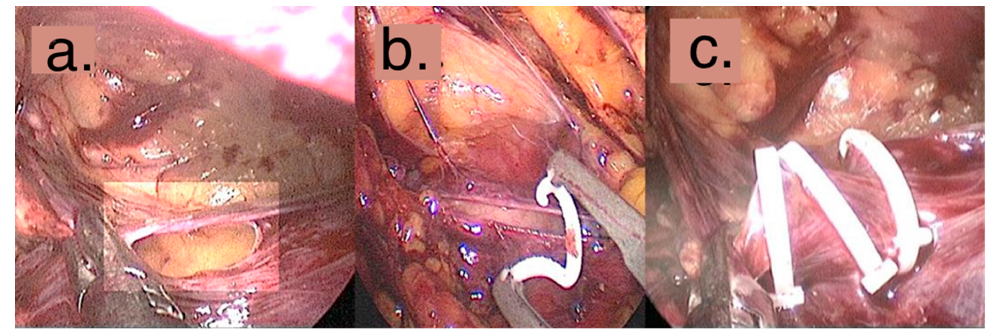
Figure 3. The peritoneal tear was repaired during the operation. ( a ) A 2 cm peritoneal tear; ( b , c ) Hem-o-lok was used to close the tear.